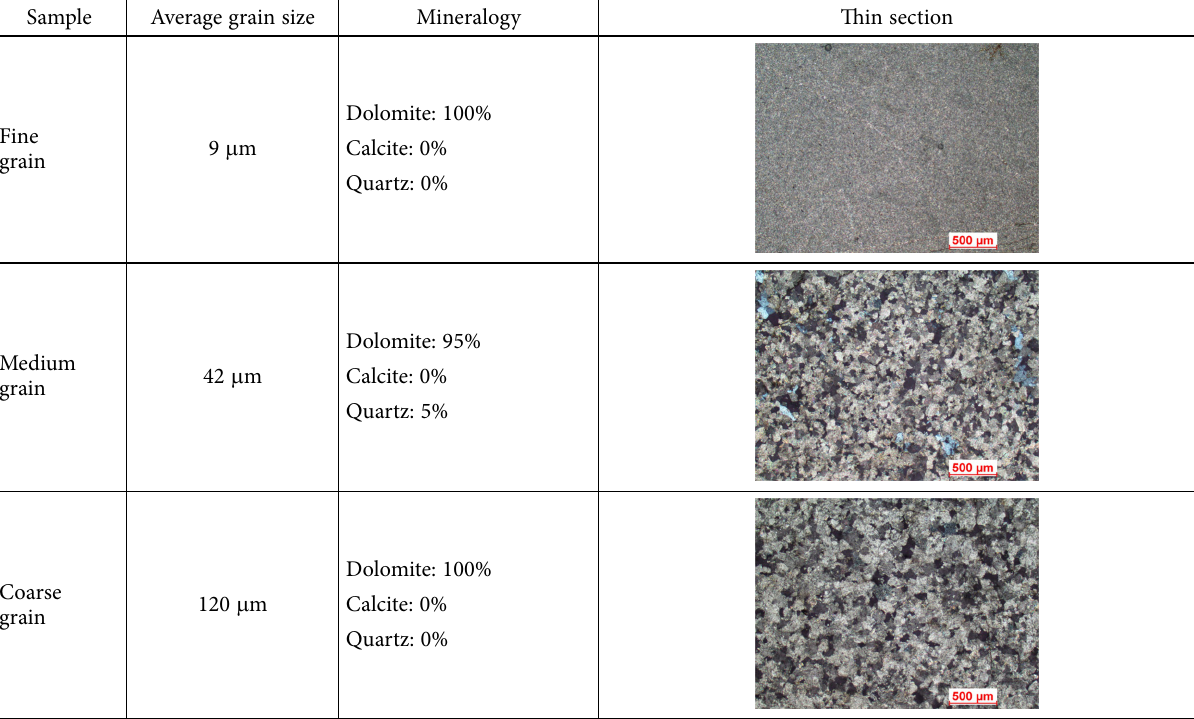
Table 1. Characteristics of three samples of the fine, medium and coarse grain dolomite rocks based on petrographic and XRD analysis Sample Thin